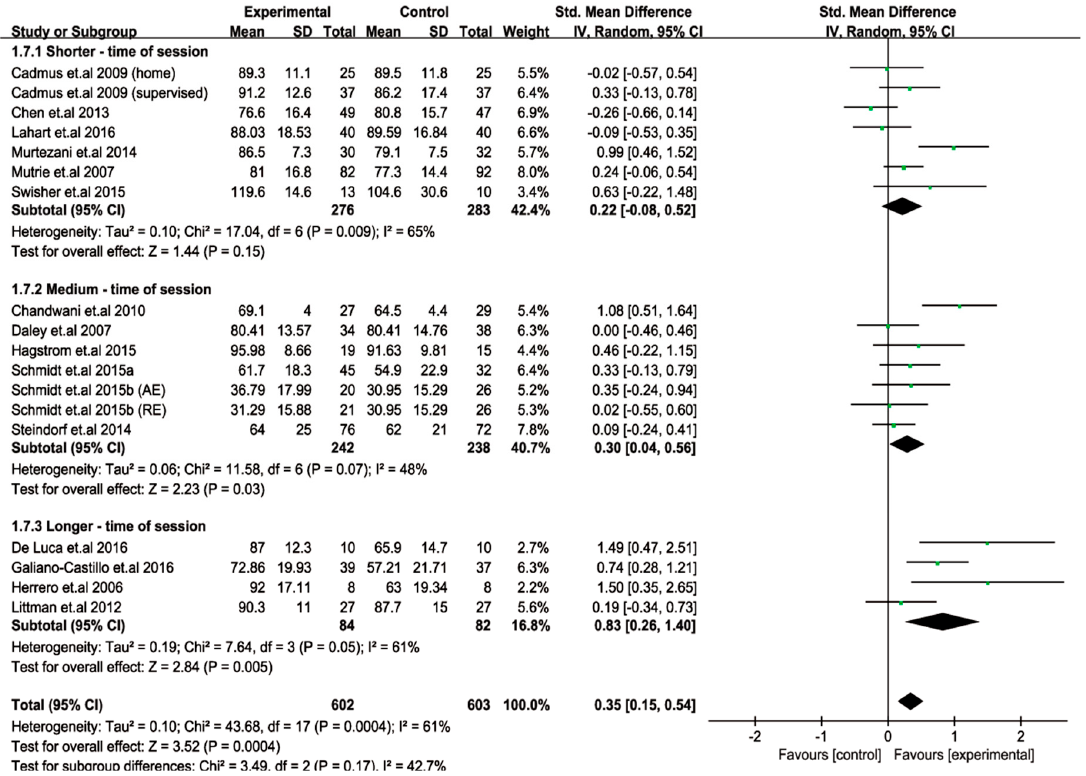
Figure 3. Forest plot of the quality of life (QoL) changes (subgroup analysis) with different times of exercise sessions in patients with breast cancer. SD, standard deviation; IV, inverse variation; CI, confidence internal; df, degrees of